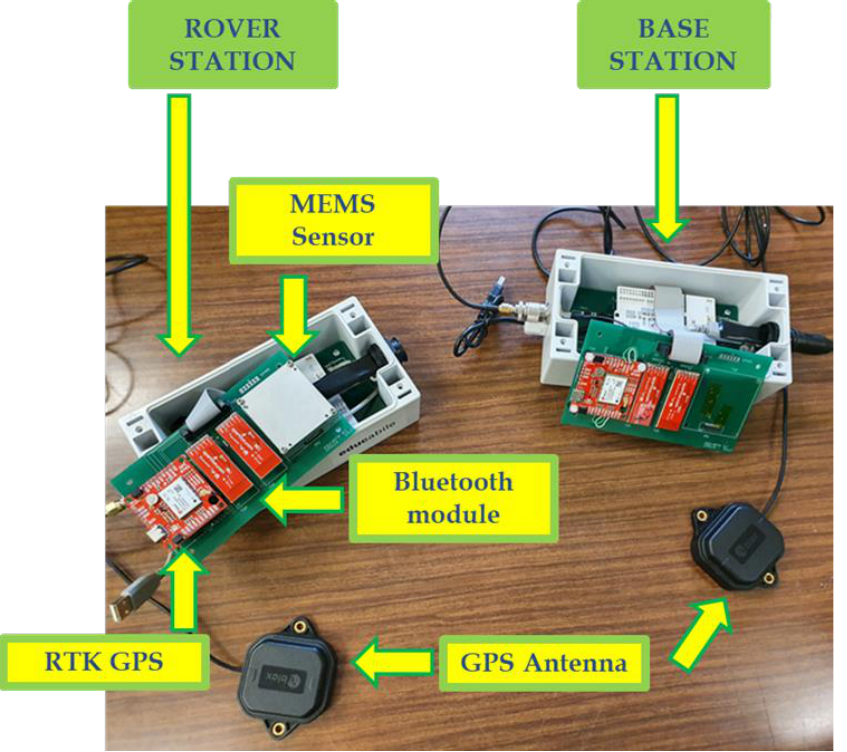
Figure 4. Realized prototype for monitoring the attitude and position of large structures.